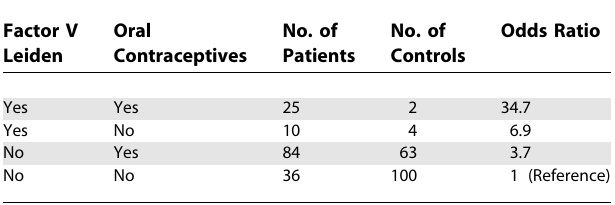
Table. Analysis of Oral Contraceptive Use, Presence of Factor V